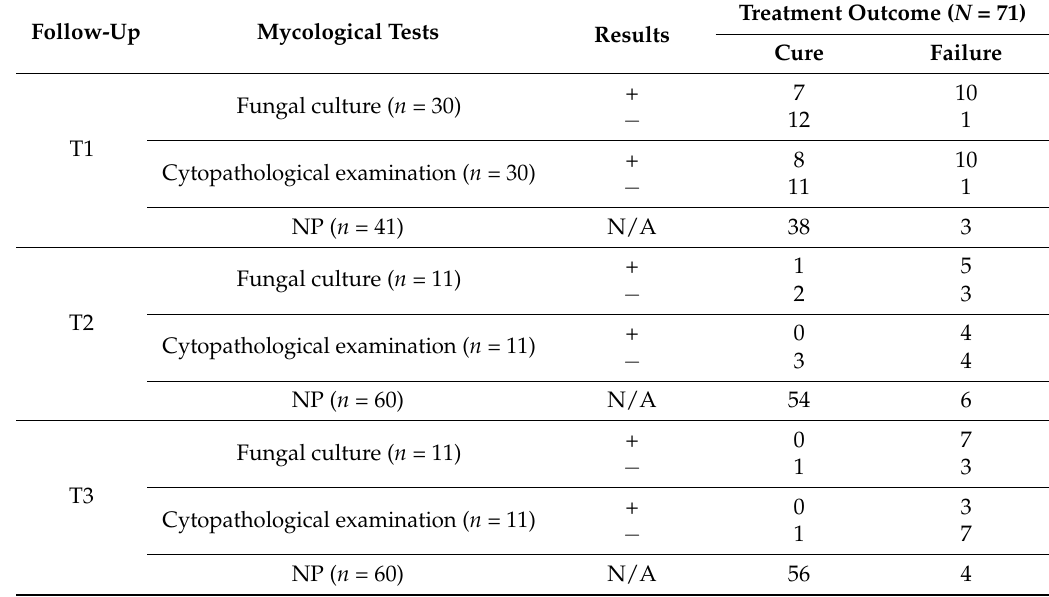
Table 5. Results of fungal culture and qualitative cytopathological examination for the detection of Sporothrix spp. in skin lesions of cats over the first three follow-up appointments, during therapy with itraconazole according to treatment outcome (cure or failure), Lapclin-Dermzoo/INI/Fiocruz